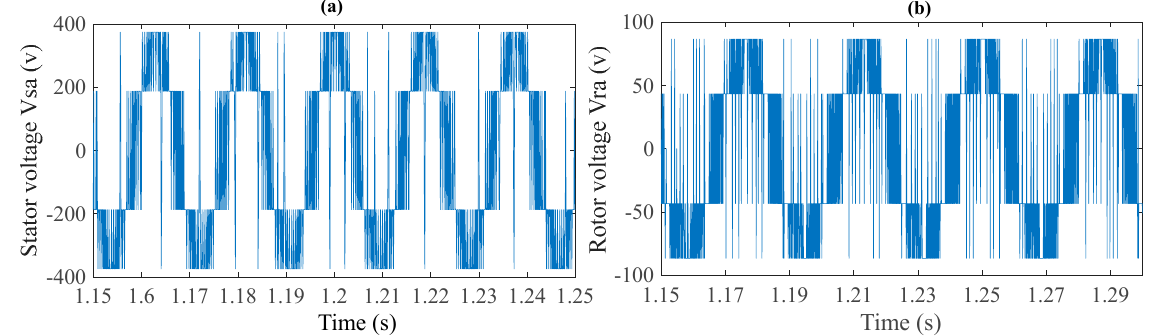
Figure 11. Stator Vsa ( a ) and rotor Vra ( b ) voltages of the DTC.